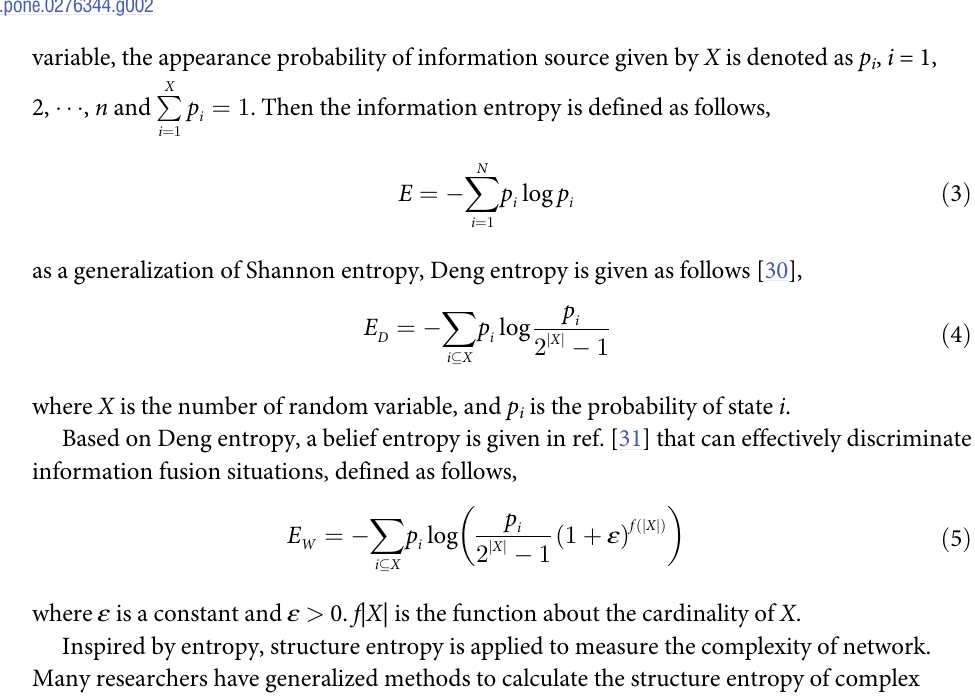
Fig 2. Example of all possible multilinks in a multiplex network with M = 2 layers and N = 5 nodes. Nodes i and j are linked by one multilink ~ m ¼ ð m ; m Þ . [21, 1 2